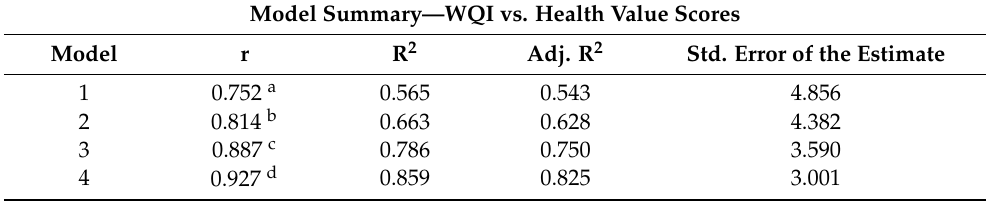
Table 4. Results of forward regression of CCME WQI versus parameters of household and community health, evaluated at all 22 sampling stations.